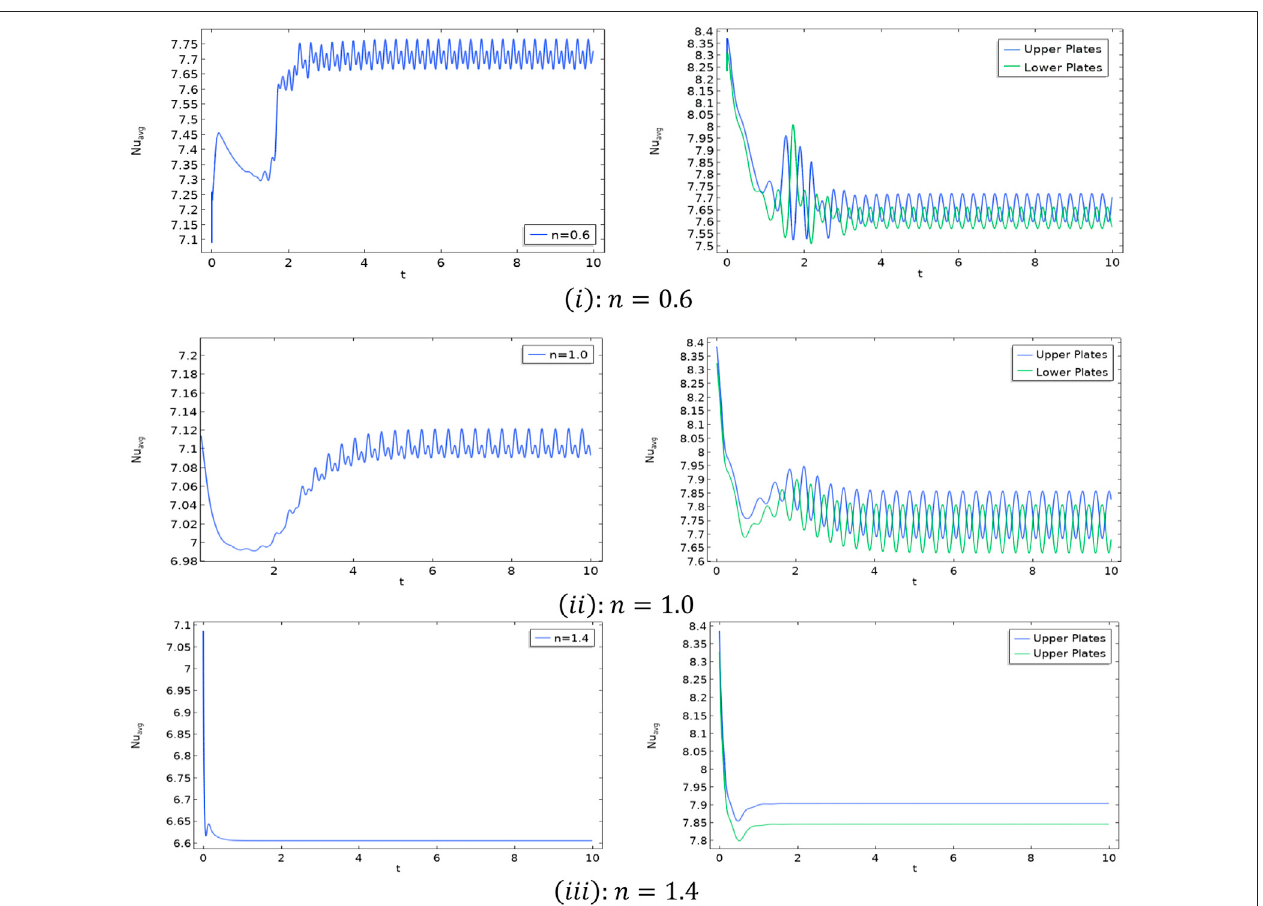
FIGURE 11 | In fl uence of n on Nu avg over the cylinder (left) and plates (right) with Pr